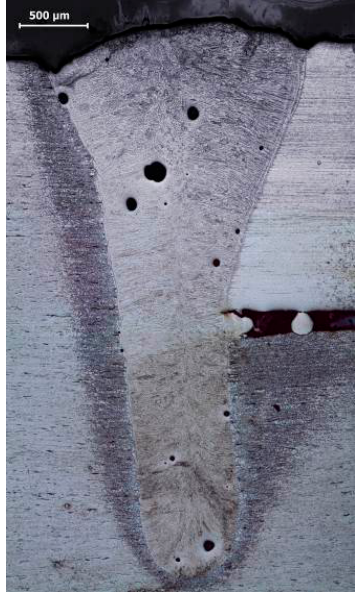
Figure 2. Macrostructure of the welded joint.